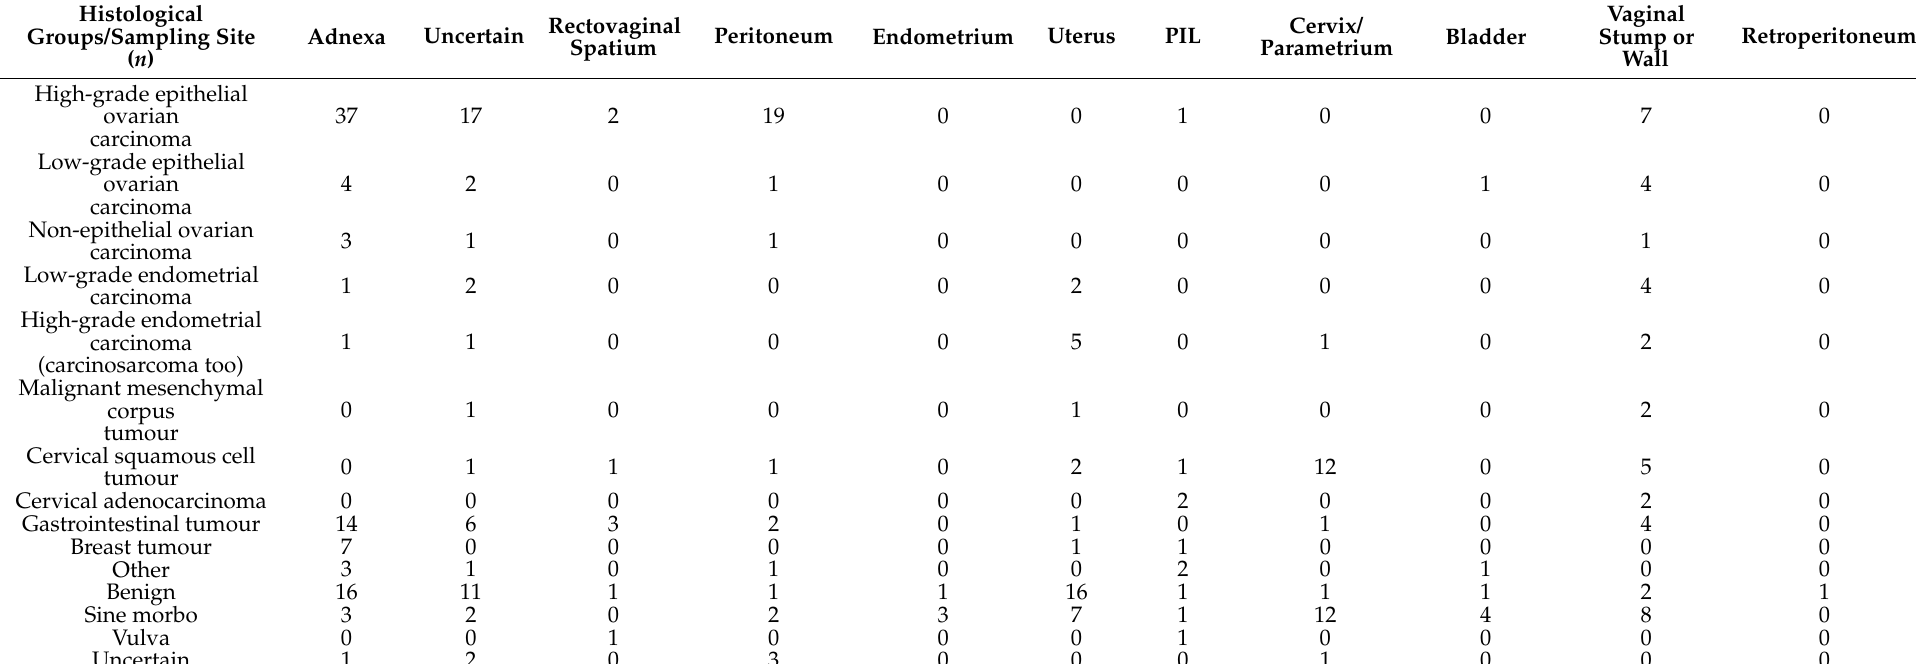
Table A2. Association of histological groups with the site of biopsy (PIL: Parailiac lymph node).